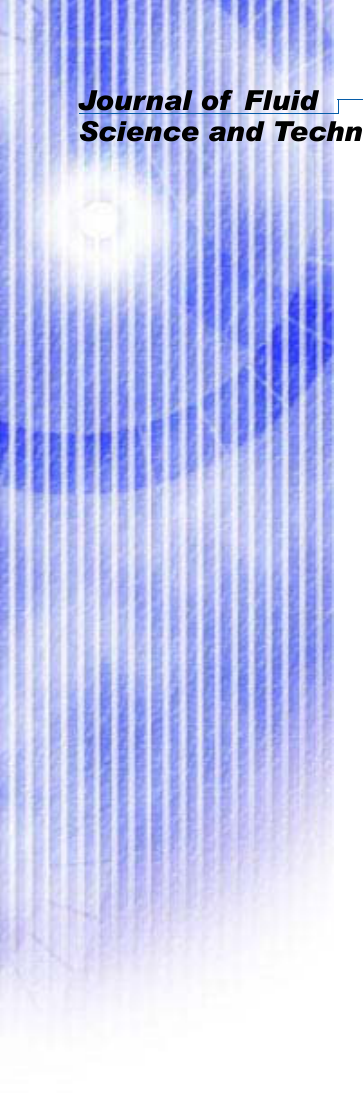
upward turning of the fluid flow due to upper position of the char exit port. The cylinder centerline while at sections 200 and 210mm its values for left side become higher than those of the right side for both cases of with and without fire-tubes inside the cylinder.